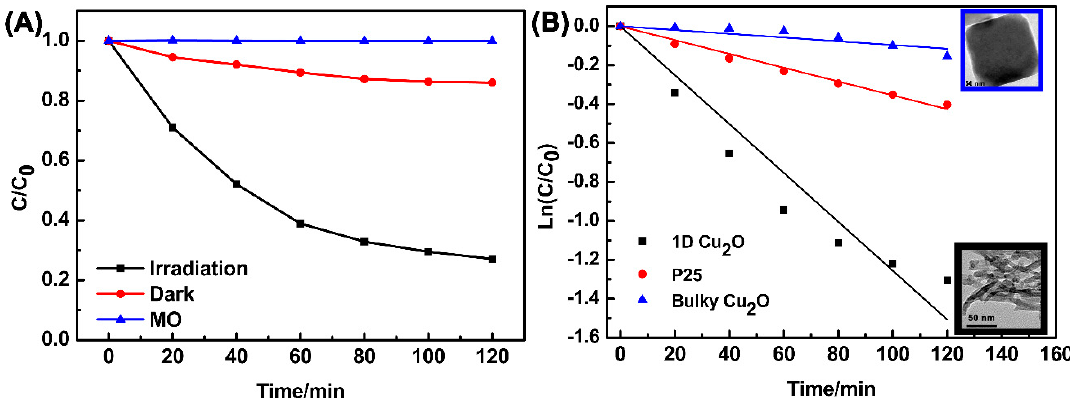
Figure 6. Photocatalytic degradation of methyl orange (MO) versus visible light irradiation duration